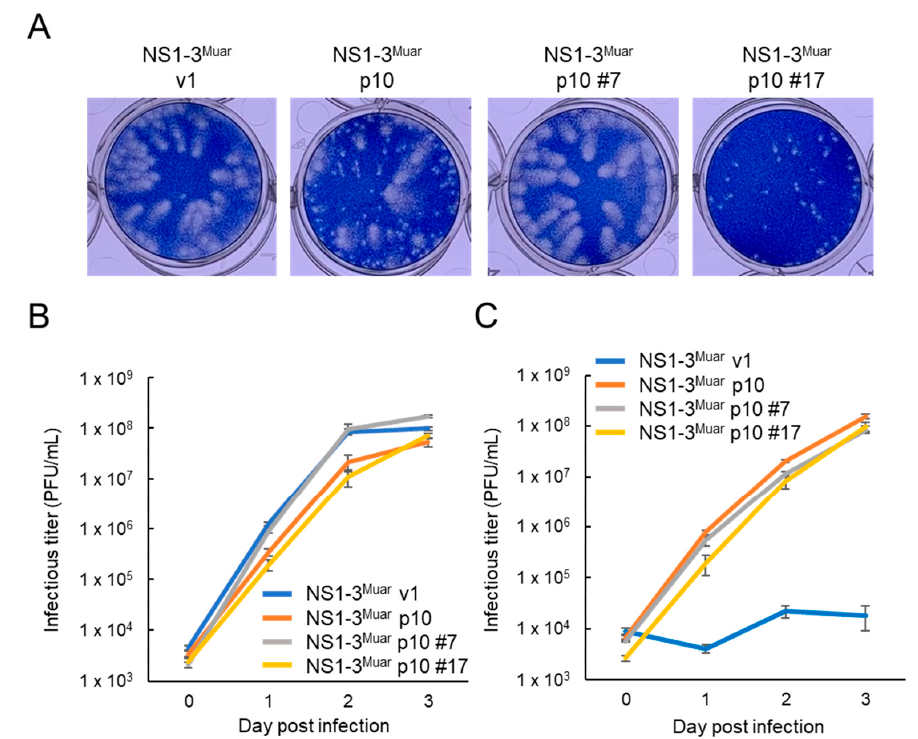
Figure 5. ( A ) Plaque phenotypes of NS1-3 Muar v1, NS1-3 Muar p10, and NS1-3 Muar p10 clones #7 (NS1-3 Muar p10#7) and #17 (NS1-3 Muar p10#17) in Vero cells. ( B , C ) Growth curves measured for NS1-3 Muar v1, NS1-3 Muar p10, NS1-3 Muar p10#7, and NS1-3 Muar p10#17 in Vero ( B ) and Neuro-2a ( C ) cells. Cells were plated into 6-well culture plates and infected with the JEV strains at an MOI of 0.1 PFU / cell. Values: mean ± standard deviation from three independent experiments.